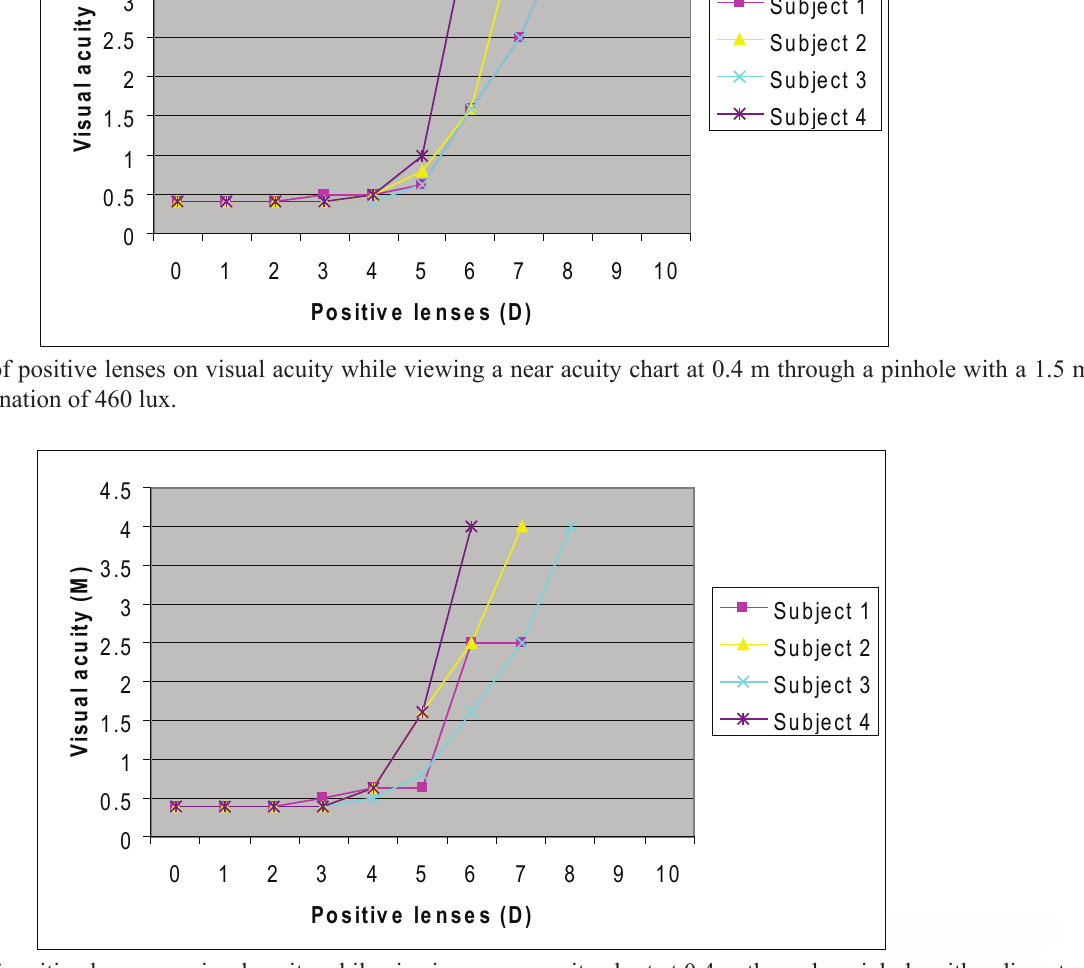
Figure 3. Effect of positive lenses on visual acuity while viewing a near acuity chart at 0.4 m through a pinhole with a diameter of 2 mm and illumination of 460